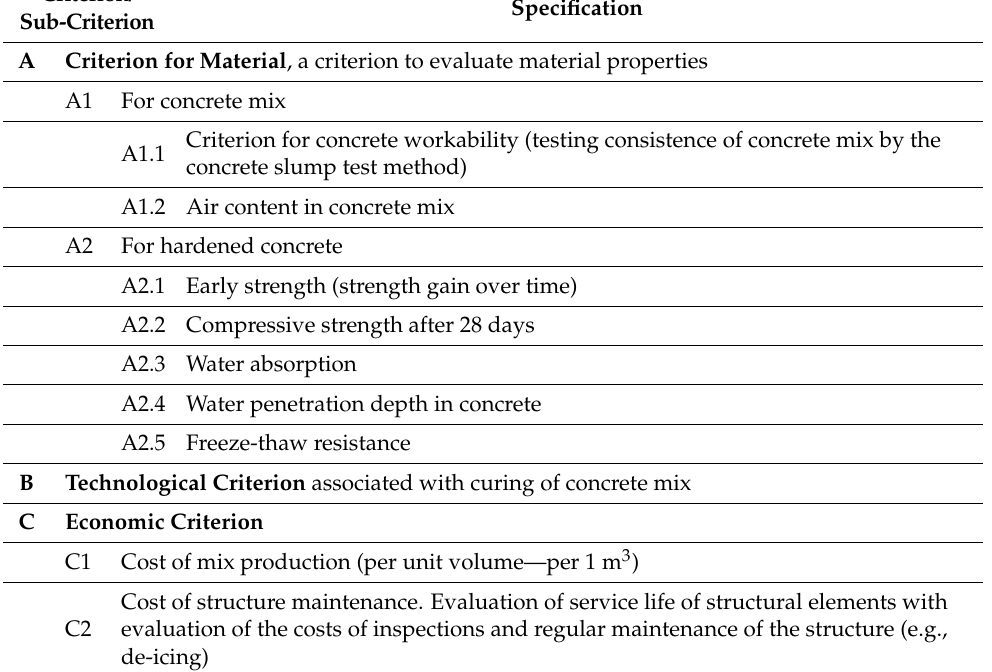
Table 3. Classification and description of evaluation criteria.